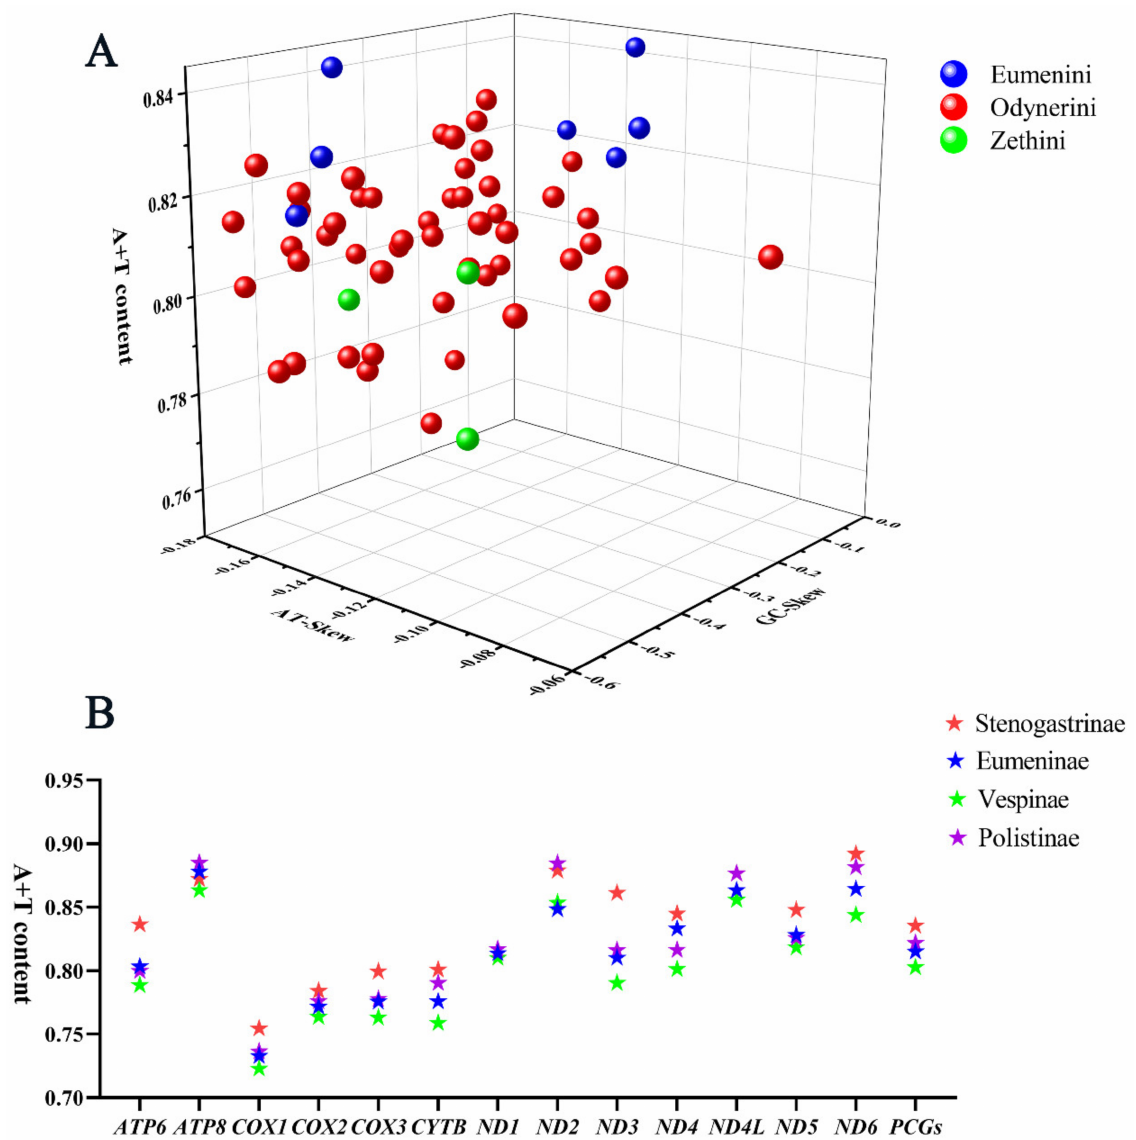
Figure 3. A+T content, AT-Skew, and GC-Skew of PCG in vespid mitogenomes. ( A ) The A+T content, AT-Skew, and GC-Skew of PCG in Eumeninae; ( B ) the A+T content of PCG in four subfamilies of